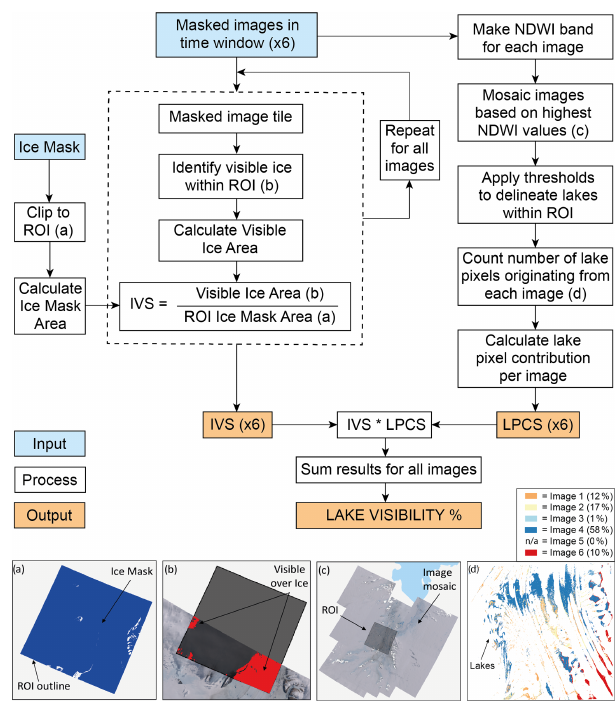
Figure 3. Flowchart detailing the method used to conduct lake visi- bility assessments within GEE for each time window. Panels (a) – (d) provide visual examples of selected stages and are referred to within the flowchart. The different lake colours in (d) indicate which op- tical image each lake pixel has originated from (e.g. orange: image 1; yellow: image 2; etc.). If the same pixel is covered by water in more than one image within a time window, the image pixel with the highest NDWI value is promoted to the mosaicked image. Six images (which are shown in Fig. S5 in the Supplement) were used in this example, indicated by × 6. IVS: image visibility score; LPCS: lake pixel contribution score; ROI: region of